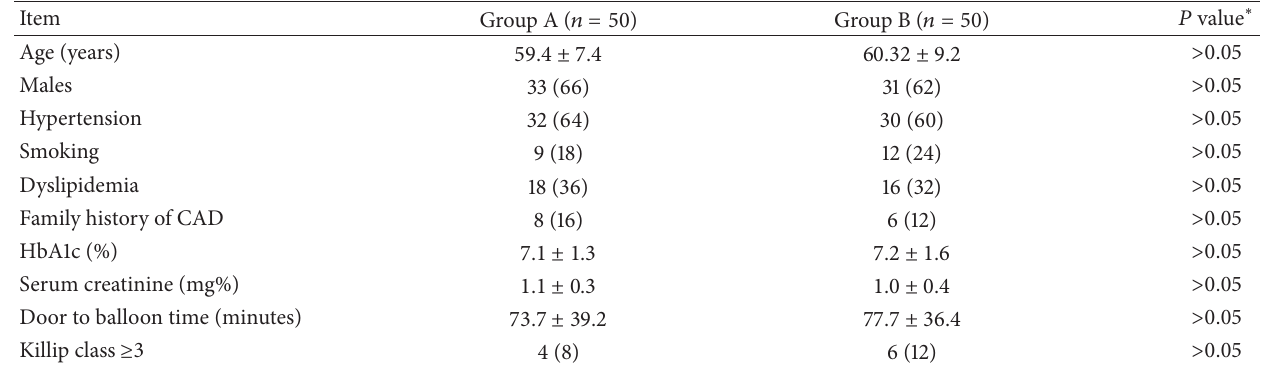
Table 1: Baseline characteristics of the two study